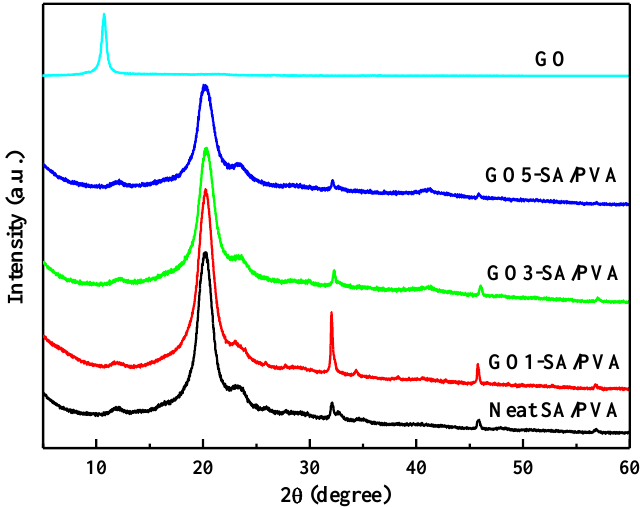
Figure 4. XRD patterns of GO, neat DN hydrogel, and GO reinforced DN hydrogels.